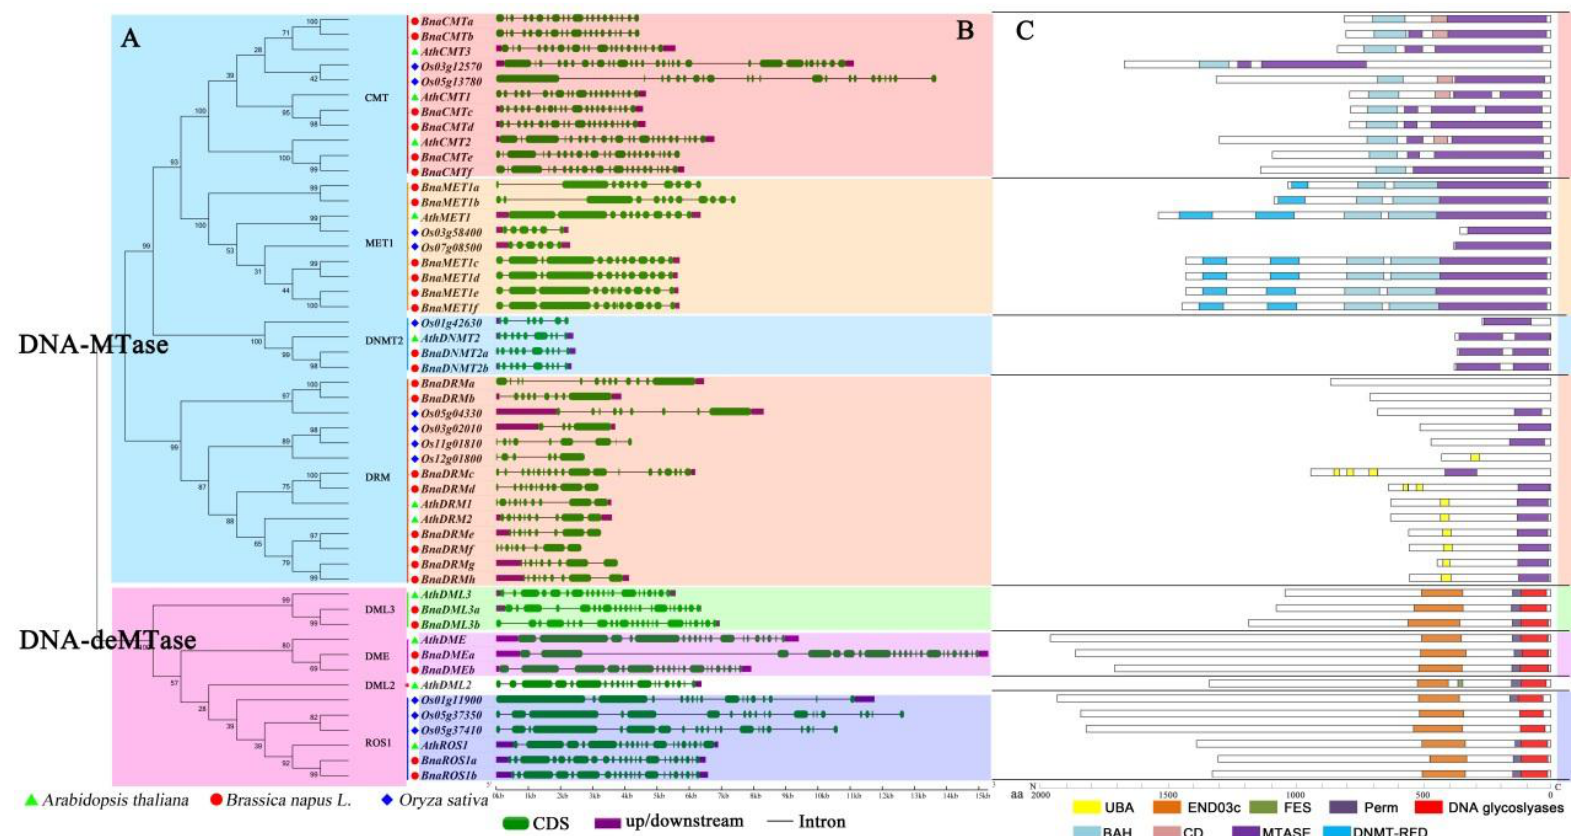
Figure 1. Evolutionary relationship, gene structure, and protein domain analysis of rapeseed DNA-MTase and DNA-deMTase gene families. ( A ): Family phylogenetic tree analysis. The evolutionary distances were computed using the Poisson correction method and are in units of “number of amino acid substitutions per site”. The analysis involved 51 amino acid sequences. All positions containing gaps and missing data were disregarded; ( B ): Gene structure. Exons are shown as green boxes, and introns are shown as black lines, upstream / downstream are shown as purple boxes. Some genes lack the annotation of upstream / downstream zone; ( C ): Protein domains. Schematic representation of conserved motifs. Colored boxes indicate di ff erent conserved